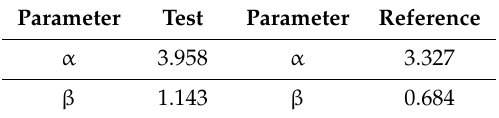
Table 5. Weibull parameters of the in vitro profile scaled up to the in vivo times. Parameter